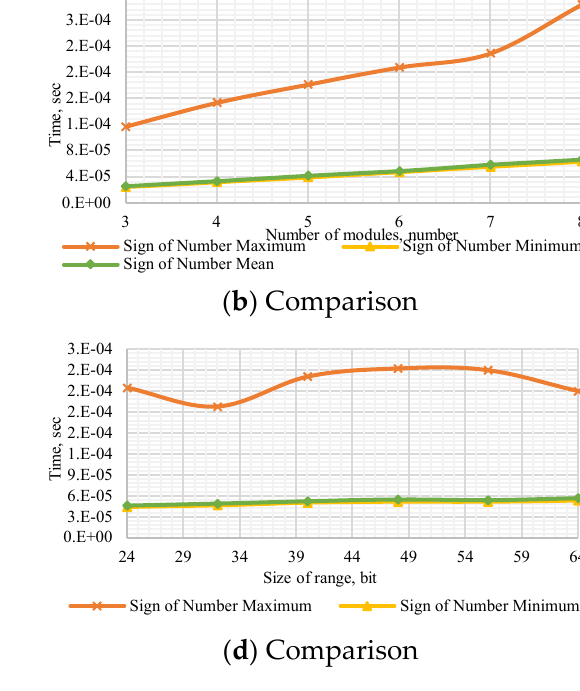
( d ) Comparison Figure A5. Performance of the Core Method to ( а ) determine the number’s sign with a dynamic number of modules (cid:1868) , ( b ) compare dynamic numbers of modules (cid:1868) , ( c ) determine the number’s sign with a dynamic bit width, and ( d ) compare numbers with dynamic bit width. ( a ) Sign